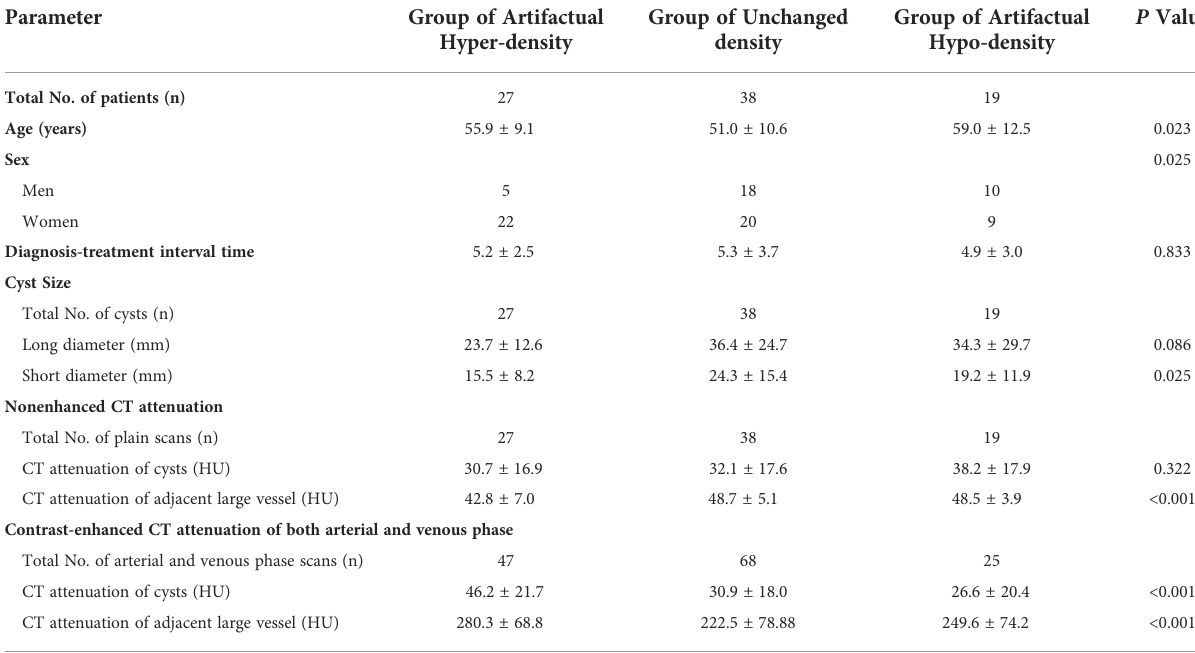
TABLE 2 Comparison of clinical characteristics and CT fi ndings between the groups with different absolute difference between the mean contrast-enhanced and nonenhanced attenuation values of thymic cysts. Parameter Group of Artifactual